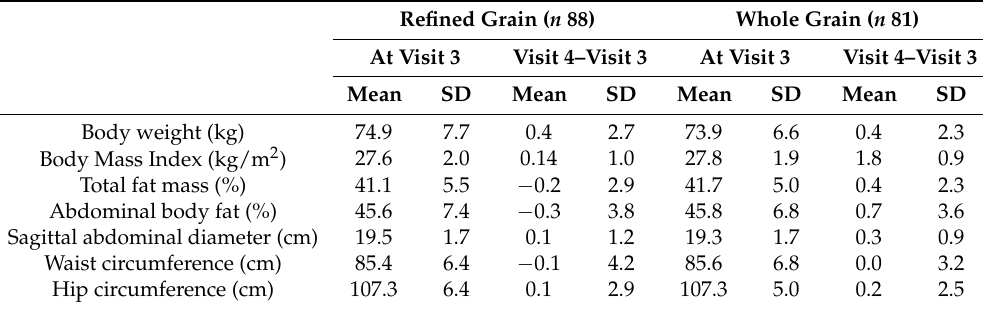
Table 3. Mean values prior to (visit 3) and unadjusted changes in cardiometabolic outcomes and plasma alkylresorcinols during the dietary intervention phase (visit 4–visit 3) in the whole ‐ grain Table 4. Mean values prior to (visit 3) and unadjusted changes in anthropometric outcomes during (WG) and refined ‐ grain (RG) groups (mean values with standard deviations (SD)). the dietary intervention phase (visit 4–visit 3) in the whole-grain (WG) and refined grain (RG) groups (mean values with standard deviations (SD)). RG Group ( n 88)